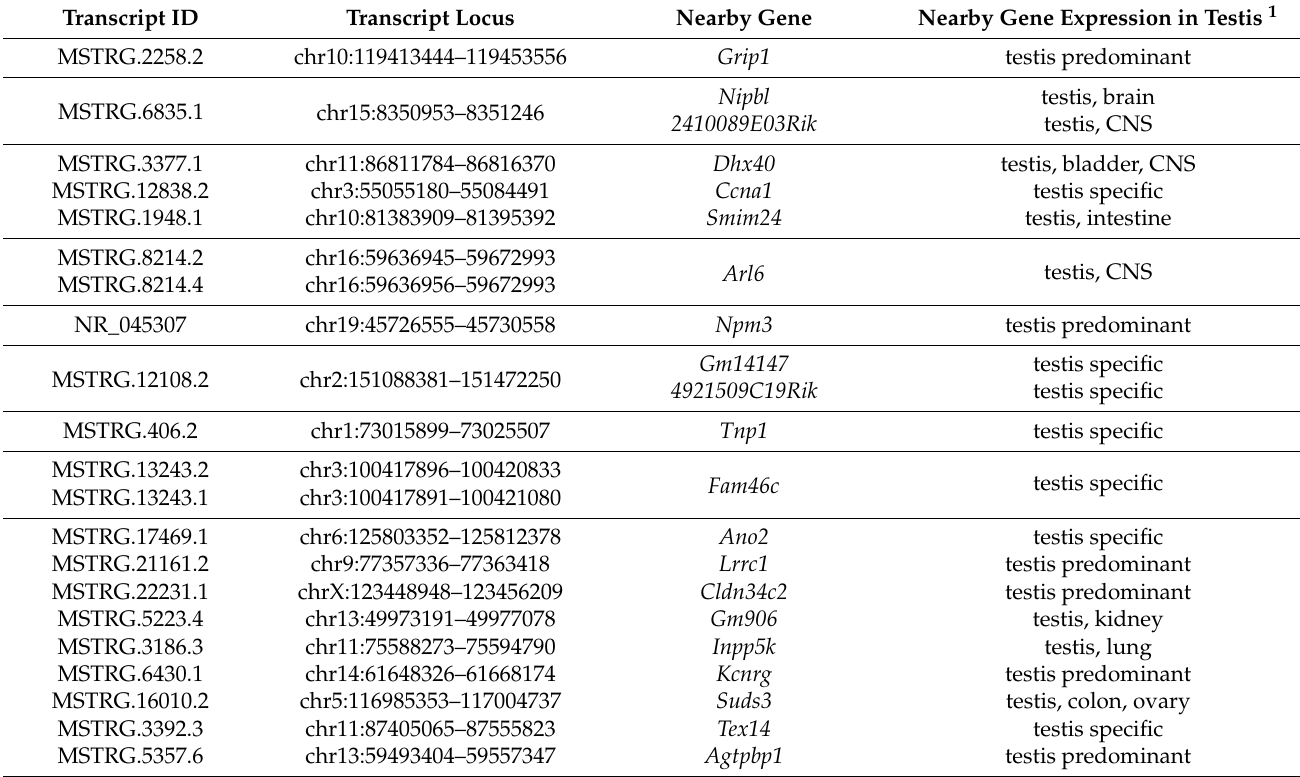
Table 4. Testis-expressed potential cis -regulatory targets of aging-related lncRNAs identified by GREAT